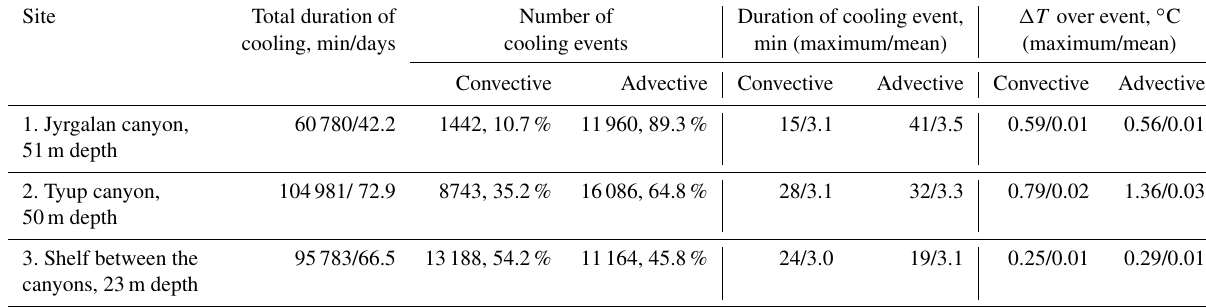
Table 1. Basic statistics of observed cooling events.